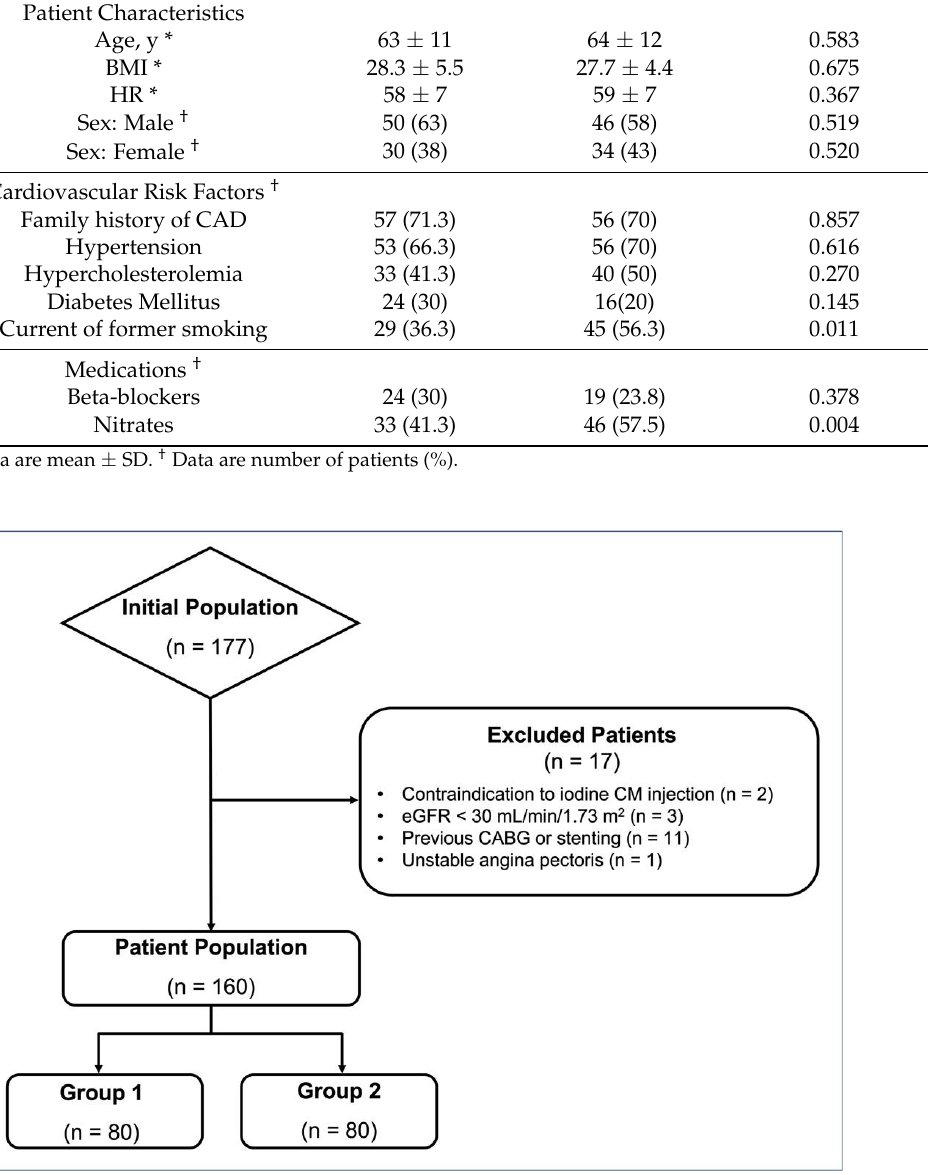
Figure 3. Flow diagram of patient recruitment (CM: contrast medium; eGRF: estimated glomerular filtration rate; CABG: coronary artery bypass grafting).